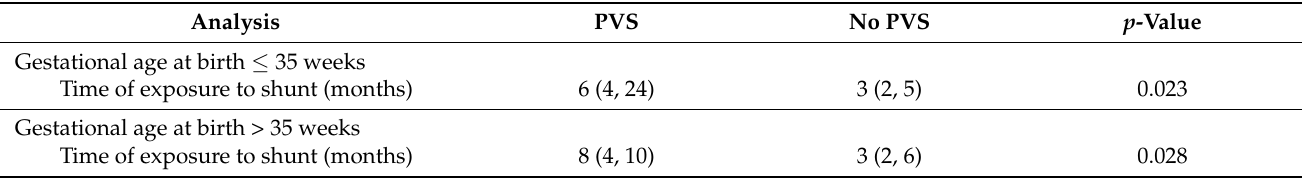
Table 5. Time of Exposure to Shunt for Patients Based on Gestational